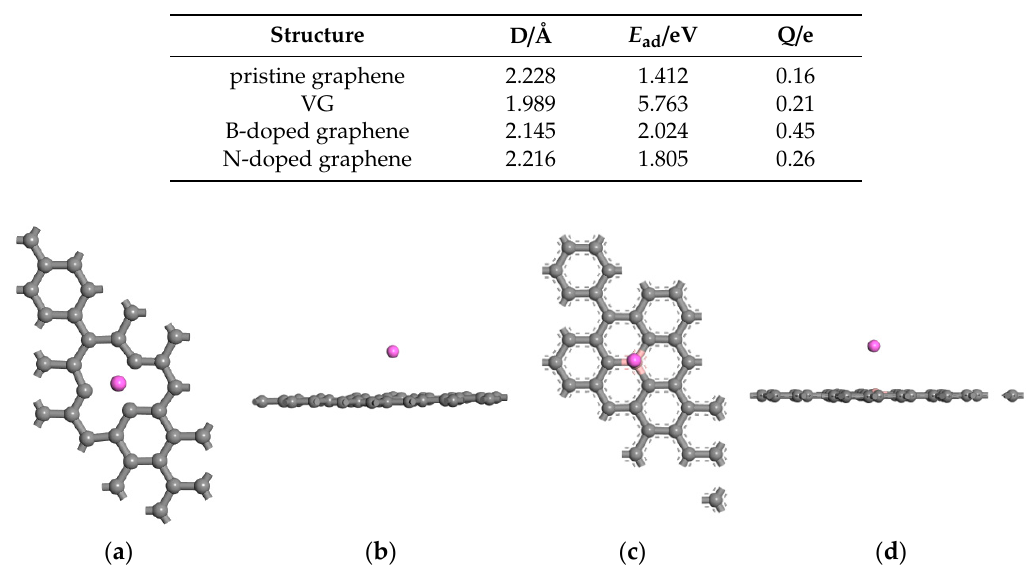
Table 1. The adsorption height (D), adsorption energy ( E ad ), and charge transfer (Q) of the Al atom absorbed on graphene.